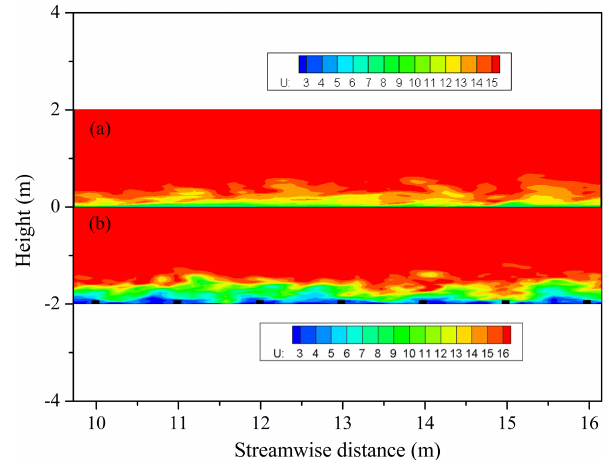
Figure 5. The side view of x – z -plane streamwise velocity be- fore (a) and after (b) containing the SCBs ( u τ = 0 . 6ms − 1 ; N = 5–20m; y = 0m). The y coordinates are correspondingly shifted down by 2m in (b)